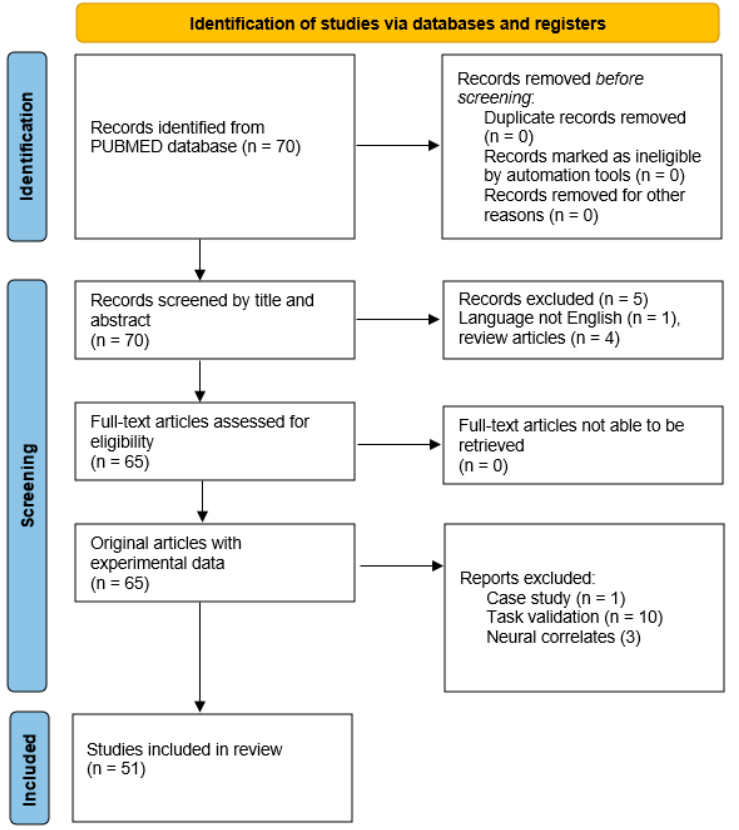
Figure 2. Search strategy: flowchart showing the number of studies included in the systemic